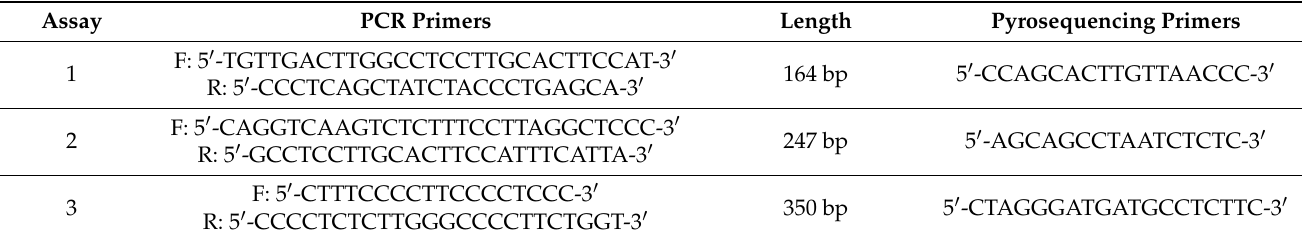
Table 2. Annealing sequences of PCR and pyrosequencing